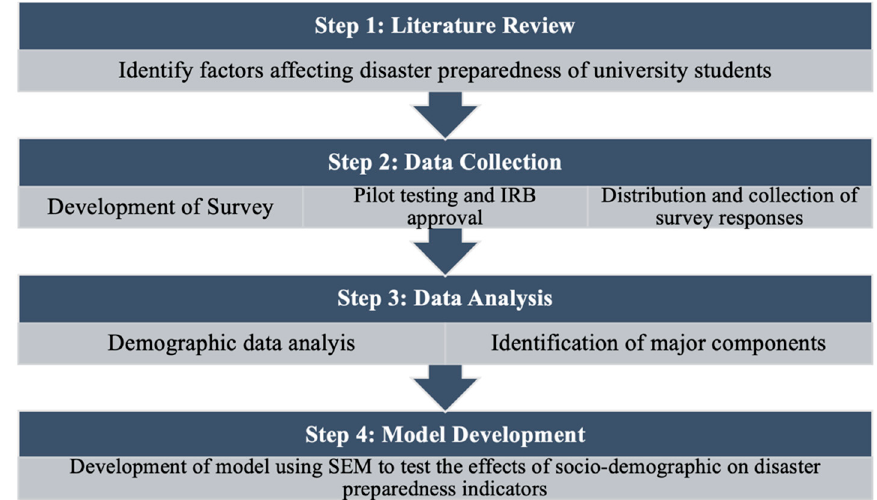
Figure 1. Research Method.